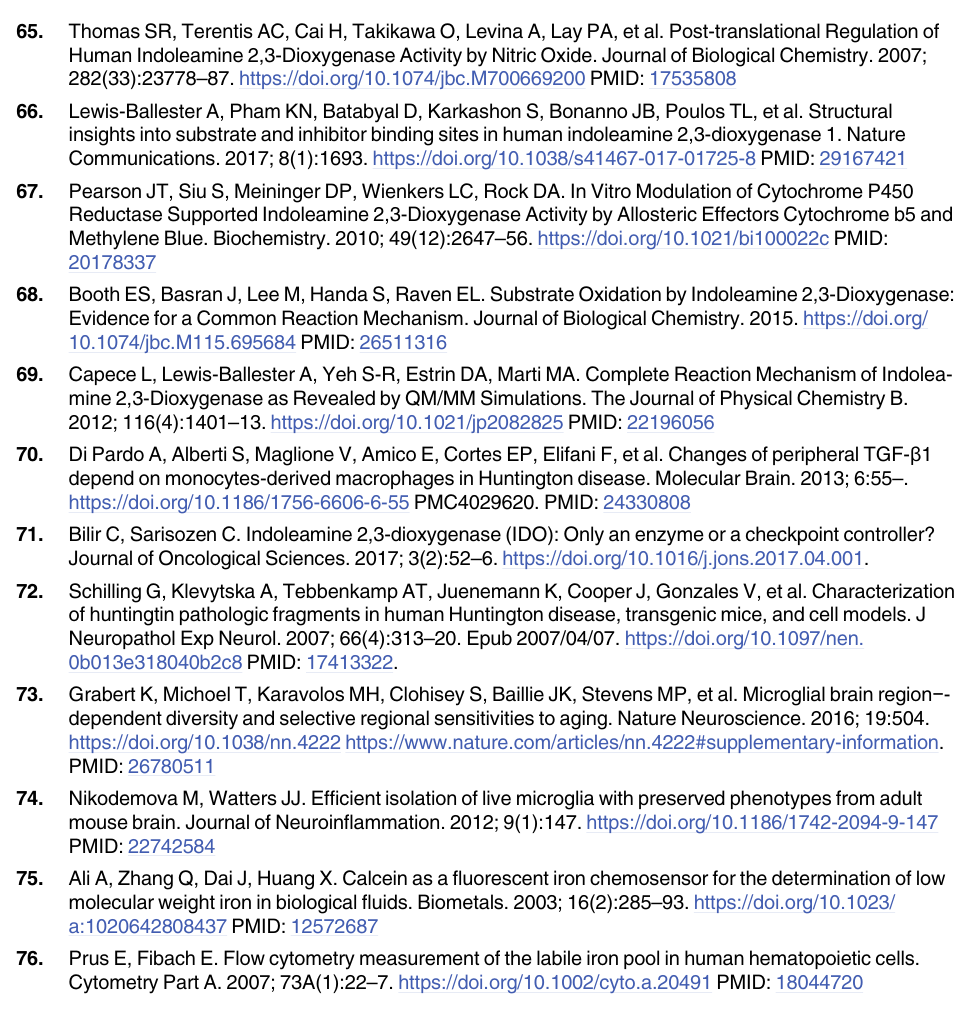
76. Prus E, Fibach E. Flow cytometry measurement of the labileiron pool in humanhematopoietic cells. Cytometry Part A. 2007; 73A(1):22–7. https://doi.org/10.1002/cyto.a.20491 PMID: